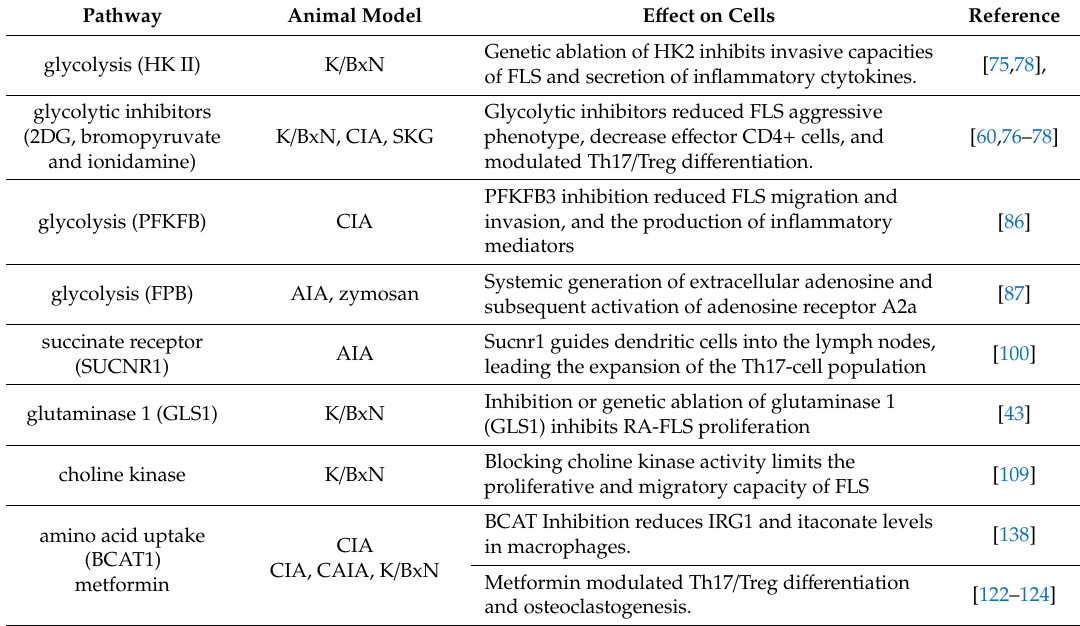
Table 3. Preclinical data of drugs that target metabolic